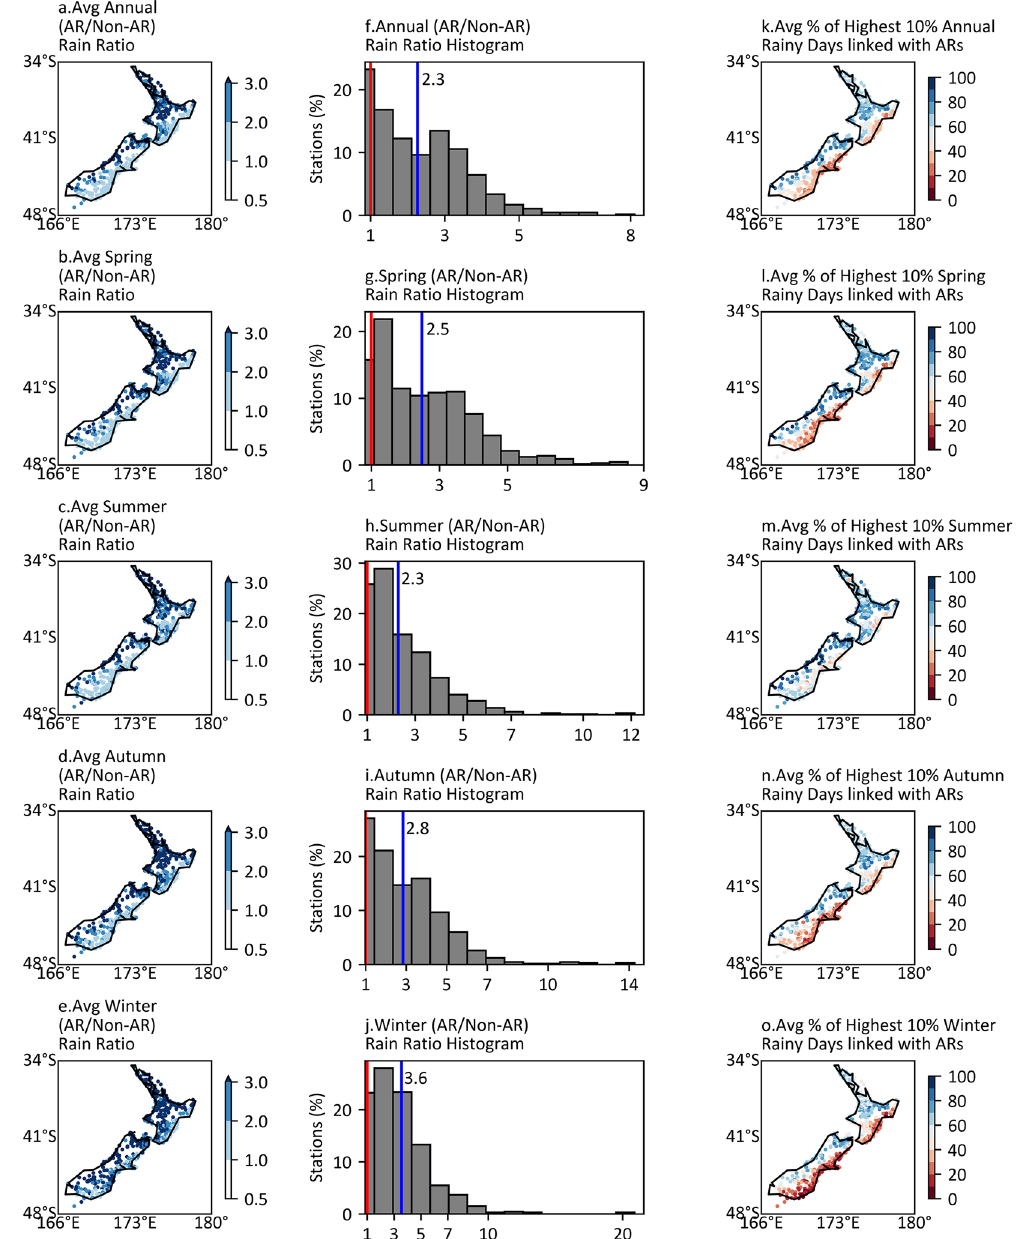
Figure 4. Maps of the average annual and seasonal AR/Non-AR rain ratio and the average percentage of the highest 10% rainy days linked with ARs, and histograms of AR/Non-AR rain ratio. ( a – e ) Annual and seasonal mean ratio of AR/Non-AR daily rainfall totals for each site. ( f – j ) Histograms of annual and seasonal mean ratio of AR/Non-AR daily rainfall totals. Red vertical lines in histograms locate the ratio 1, and blue vertical lines indicate the median values. ( k – o ) Annual and seasonal average percentage of the highest 10% rainy days linked with ARs. Note that months of seasons are: Spring (SON), Summer (DJF), Autumn (MAM), Winter